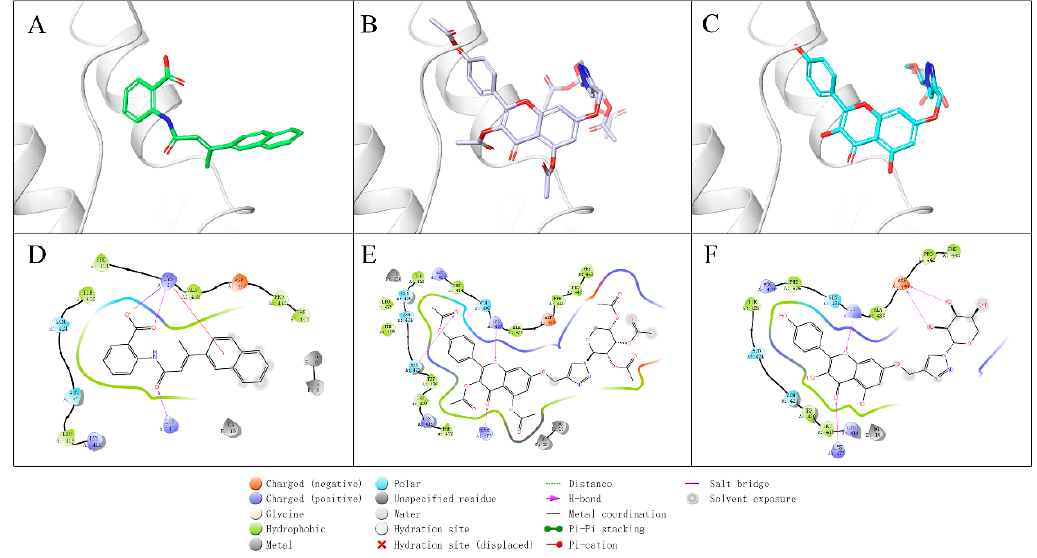
Figure 8. Binding mode of compounds with telomerase. ( A ) 3D ligand interaction diagram of BIBR1532 with telomerase. ( B ) 3D ligand interaction diagram of compound 5c with telomerase. ( C ) 3D ligand interaction diagram of compound 6c with telomerase. ( D ) 2D ligand interaction diagram of BIBR1532 with telomerase. ( E ) 2D ligand interaction diagram of compound 5c with telomerase. ( F ) 2D ligand interaction diagram of compound 6c with telomerase.